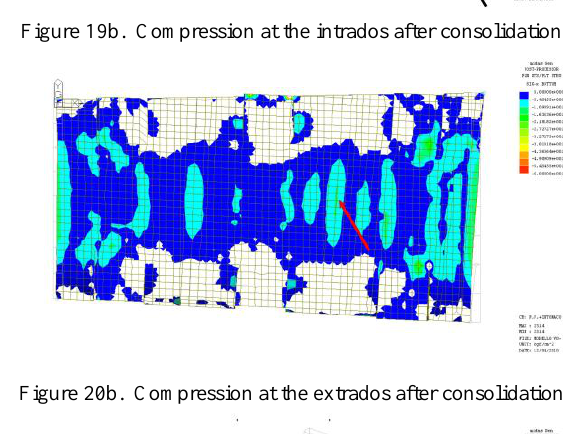
Figure 19b. Compression at the intrados after consolidation